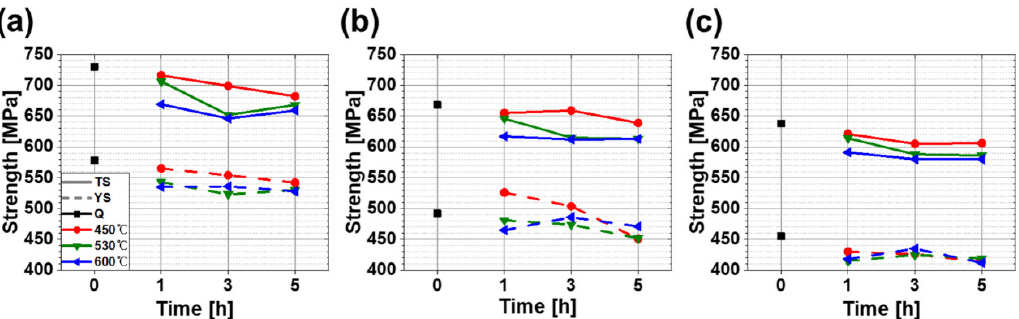
Figure 9. Tensile properties of ( a ) FC ( − 10.6 ◦ C / s), ( b ) MC ( − 4.6 ◦ C / s), ( c ) SC ( − 2.5 ◦ C / s) specimens according to tempering conditions. The solid line and dotted line show tensile strength and yield strength. Tempering conditions represented in black, red, green and blue mean quenching, 450, 530 and 600 ◦ C, respectively.